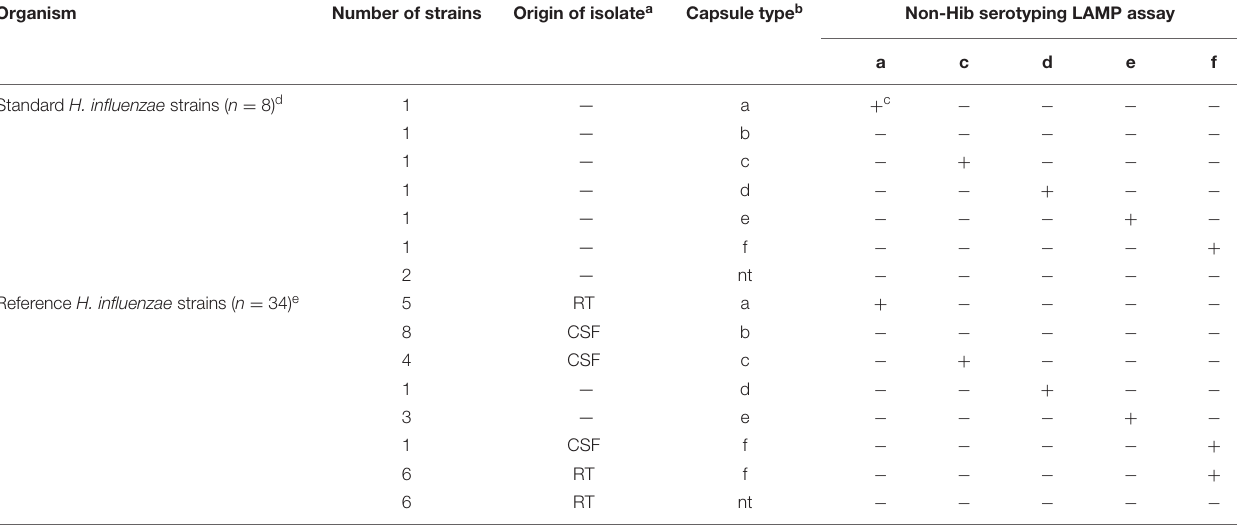
TABLE 1 | Reactivity and specificity of the non-Hib serotyping LAMP assay. Organism